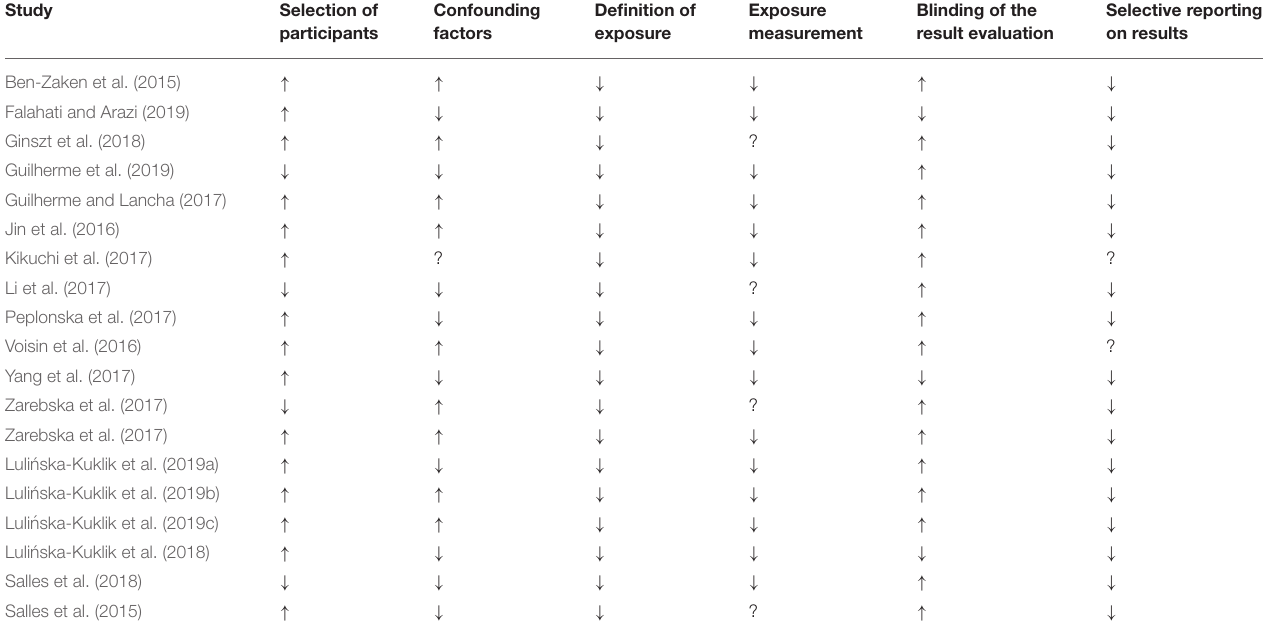
Confounding Definition of Exposure Blinding of the participants factors exposure measurement result evaluation